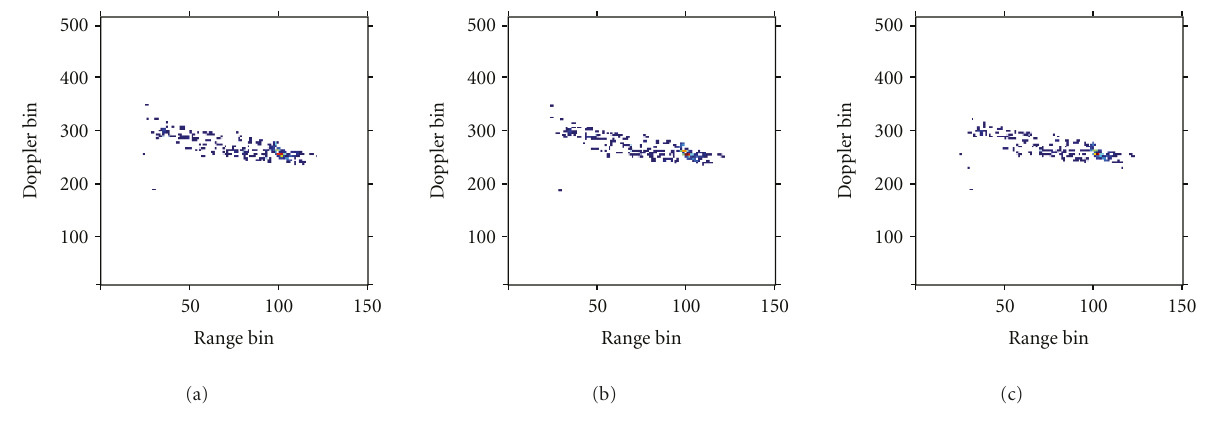
Figure 11: Instantaneous ISAR images based on the IHMPT.